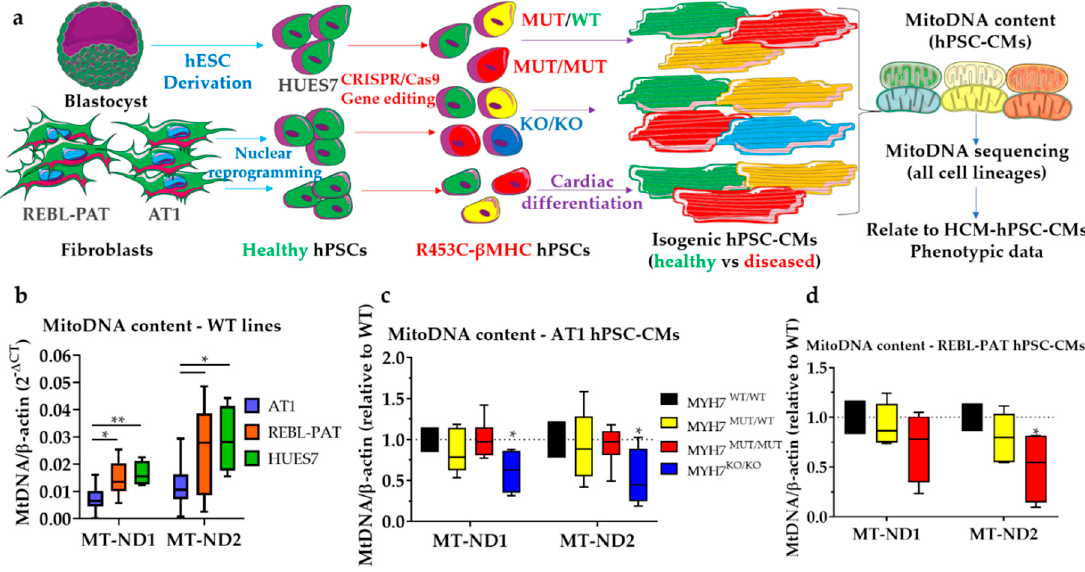
Figure 1. Harnessing isogenic hPSC-CM models to investigate varying HCM mitochondrial phenotypes. ( a ) Study workflow: hPSC were generated from three different healthy cell sources, followed by